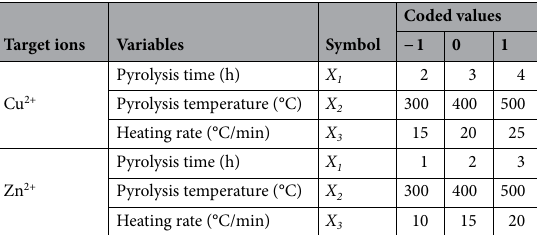
Table 1. Coded and actual values for independent